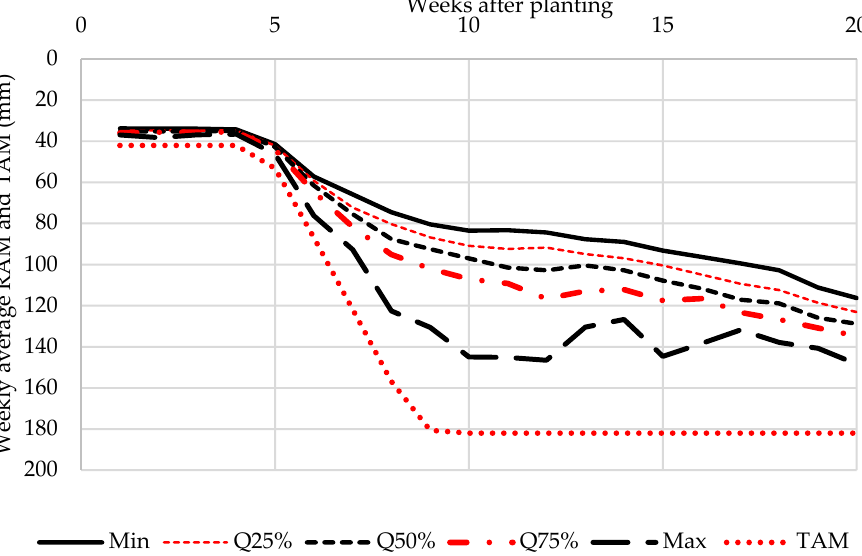
Figure 4. Weekly average daily total available moisture (TAM) and readily available moisture (RAM) for quantiles minimum (Min), 25% (Q25%), 50% (Q50%), 75% (Q75%), and maximum (Max).